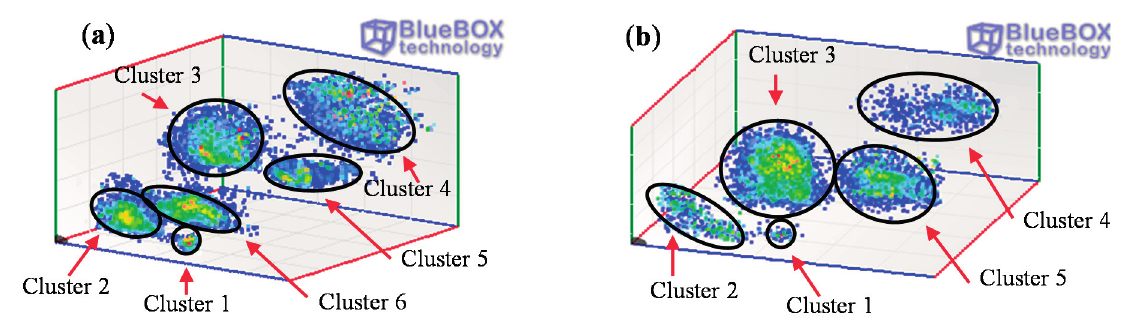
Figure 20. Result of the PD classification tool for the acquisitions with HFCT sensors 1 ( a ) and 2 ( b